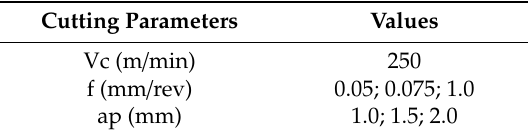
Table 1. The cutting parameters used in research.